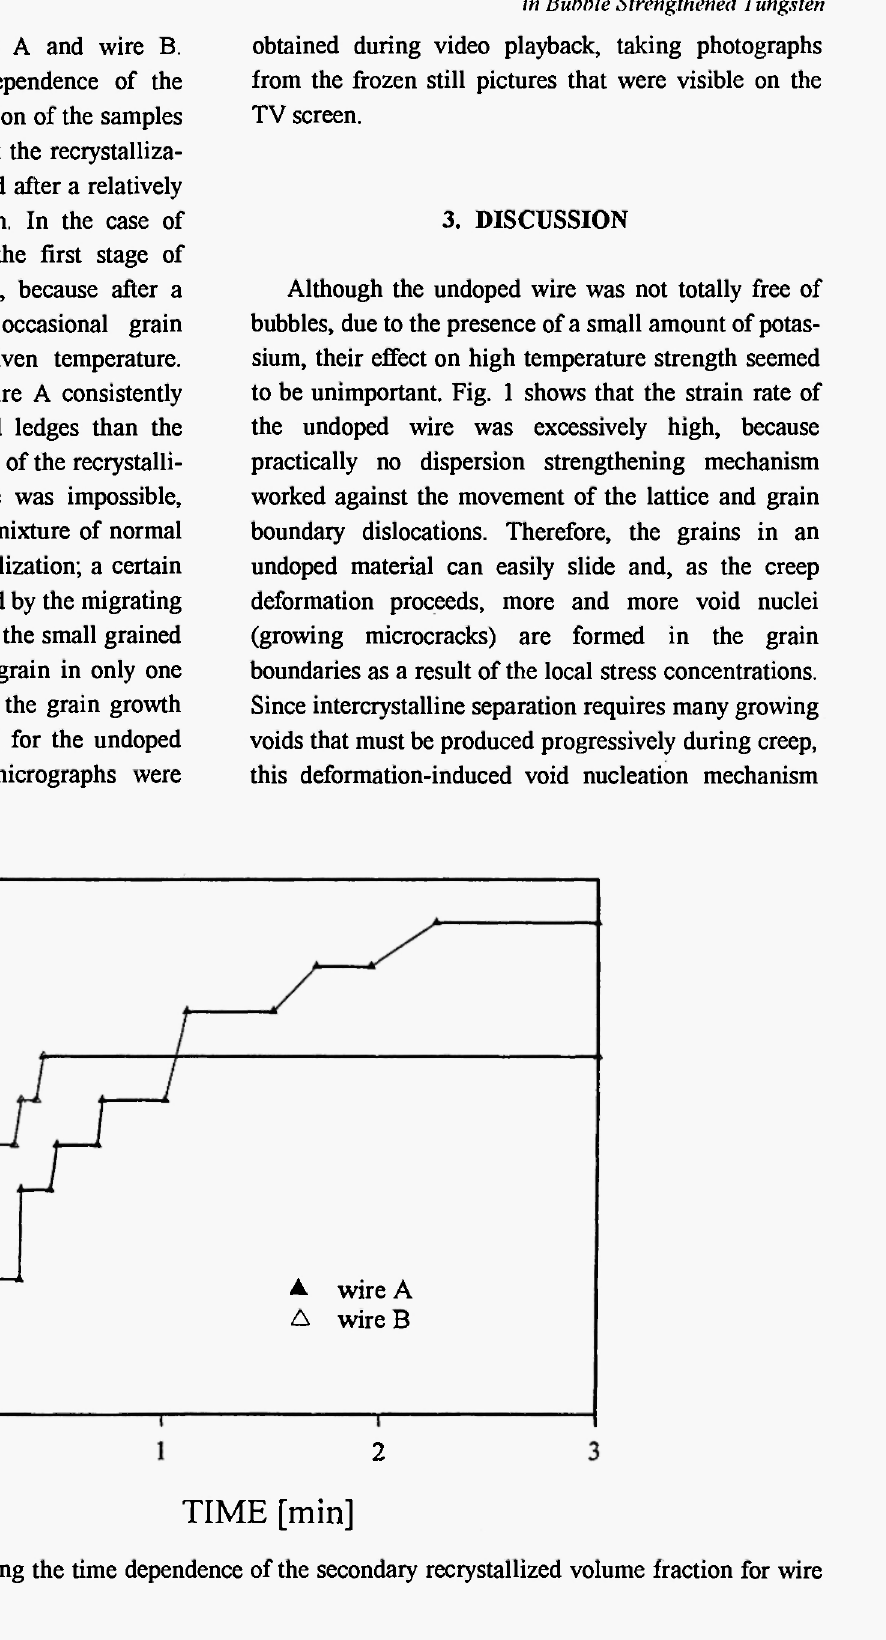
Fig. 4: Typical kinetic plots showing the time dependence of the secondary recrystallized volume fraction for wire A and wire